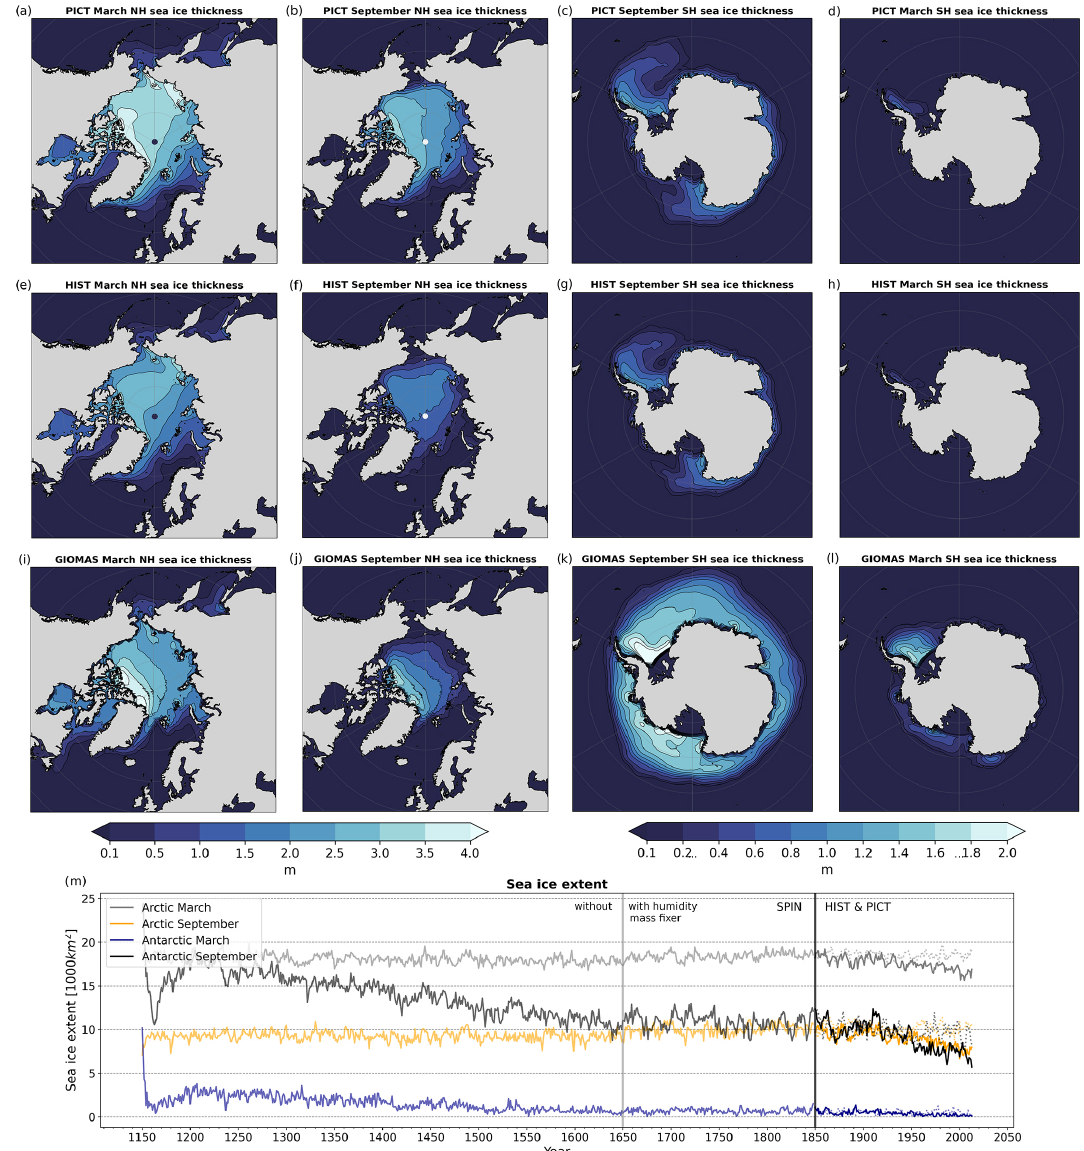
Figure 4. (a–d) Mean sea ice volume per unit area over last 25 years of the PICT simulation. (e–h) Same as top row but for the HIST simulation. (i–l) Same as top row but for the GIOMAS sea ice thickness reanalysis product. (Zhang and Rothrock, 2003). (m) Evolution of sea ice extent over SPIN, as well as HIST and PICT simulations. Mass fixer switched from dry to total in years 1650. HIST and PICT forcing applied from 1850